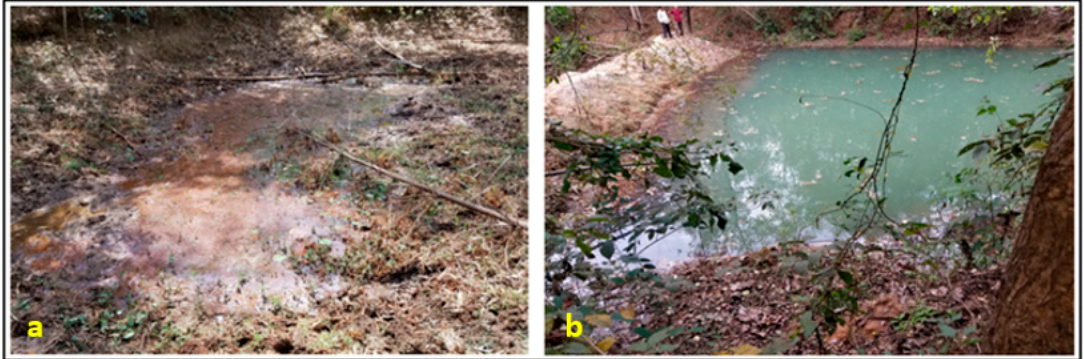
Figure 2. Status of representative minor irrigation tanks in the study area: ( a ) Keresara tank with high siltation and debris; ( b ) Devarakeri tank, newly de-silted, allowing for sheet flow and groundwater recharge. The majority of the tanks in the area are like the one in ( a ).